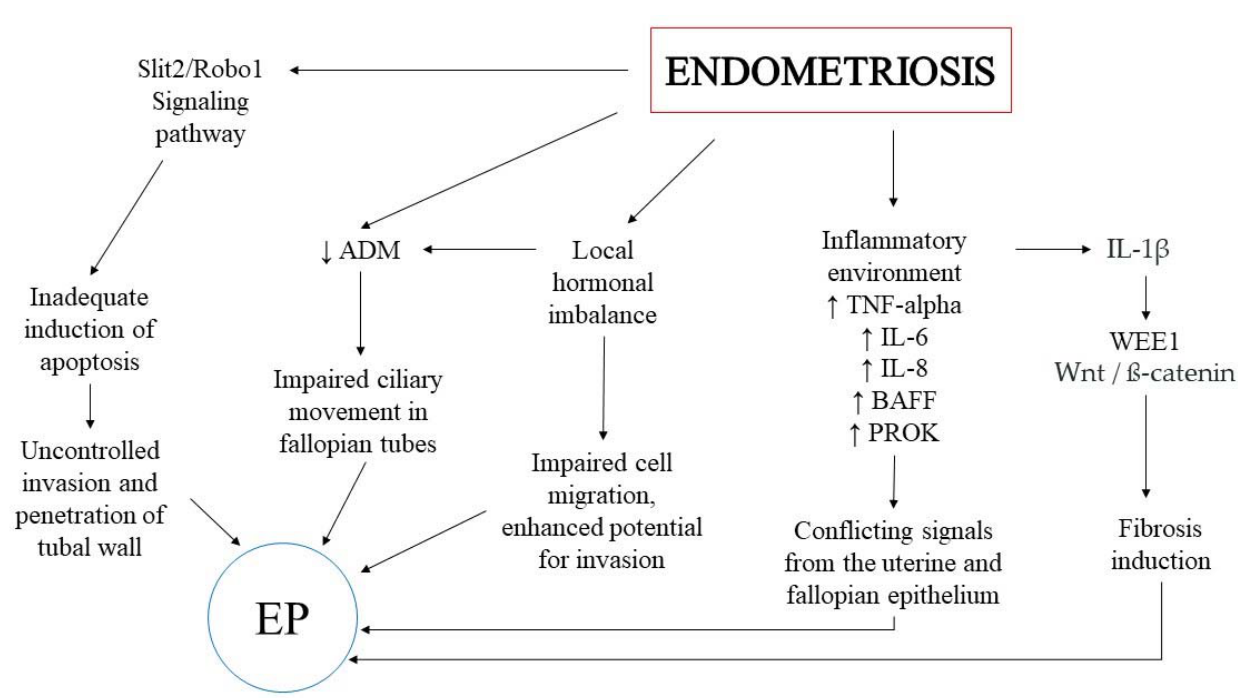
Figure 2. Potential relationships between endometriosis and EP related to the inflammatory environ- ment, the Wnt/ß-catenin pathway, and hormonal regulation.